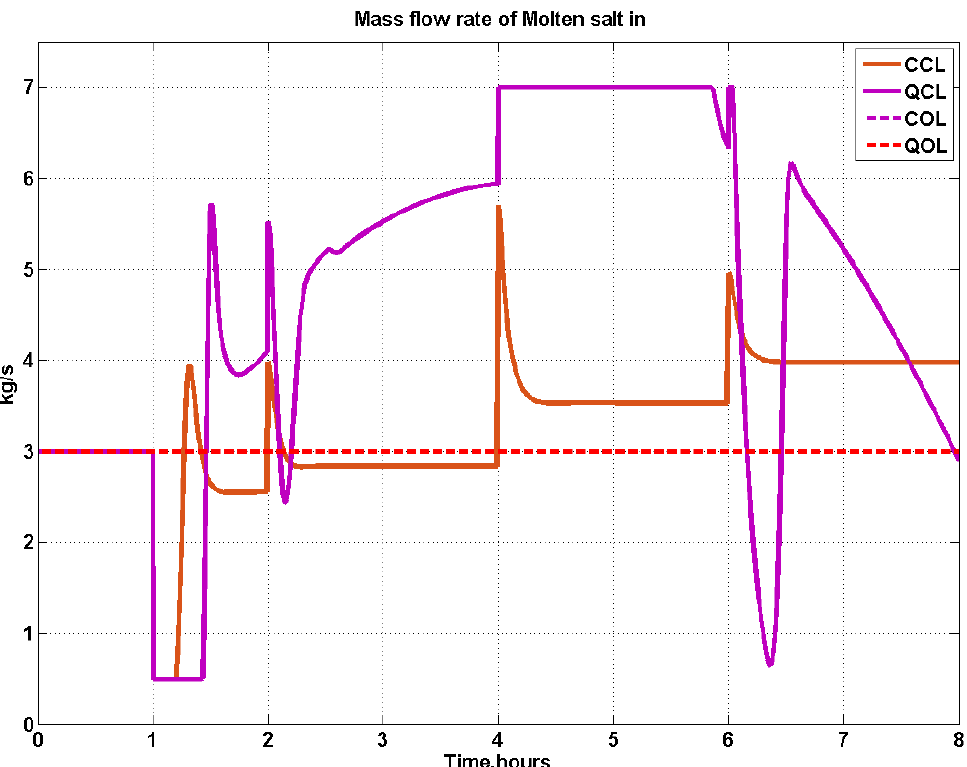
Figure 14. Manipulated variables (MV) of molten